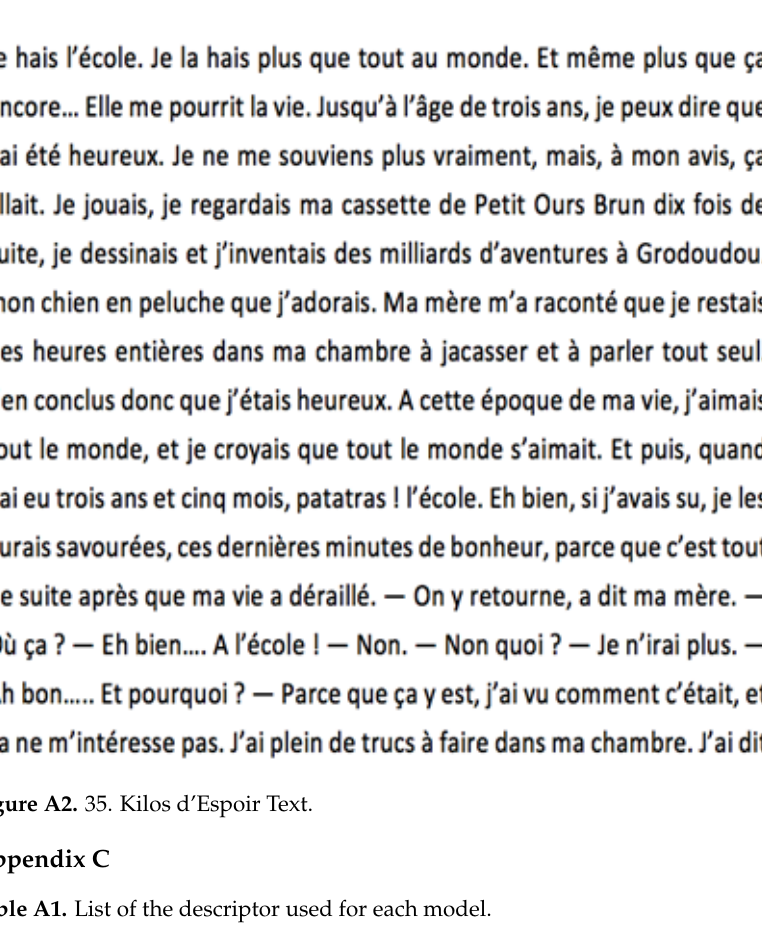
Figure A2. 35. Kilos d’Espoir Text. Figure A2 . 35. Kilos d’Espoir Text.